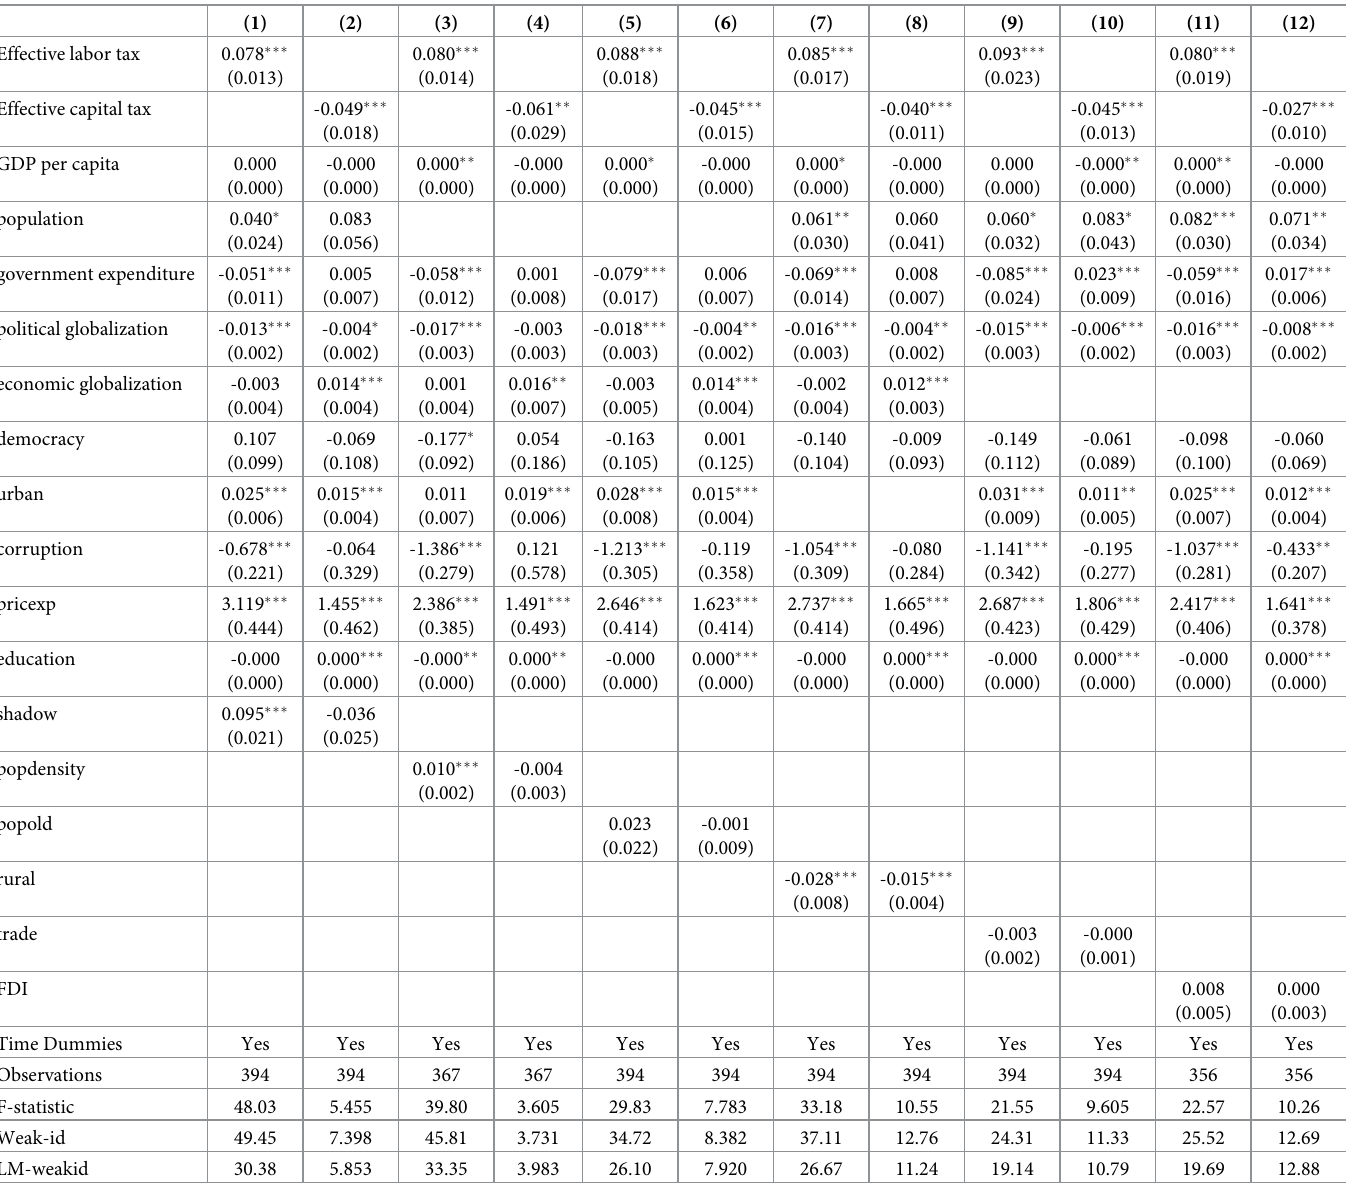
Table 7. The impact of effective taxation on economic sophistication: Robustness